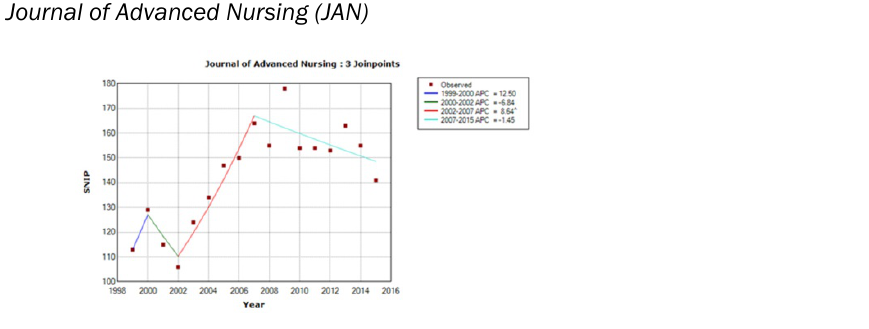
SNIP values in the y-axis are shown without a decimal point (e.g., a SNIP value of 1.00 is represented as